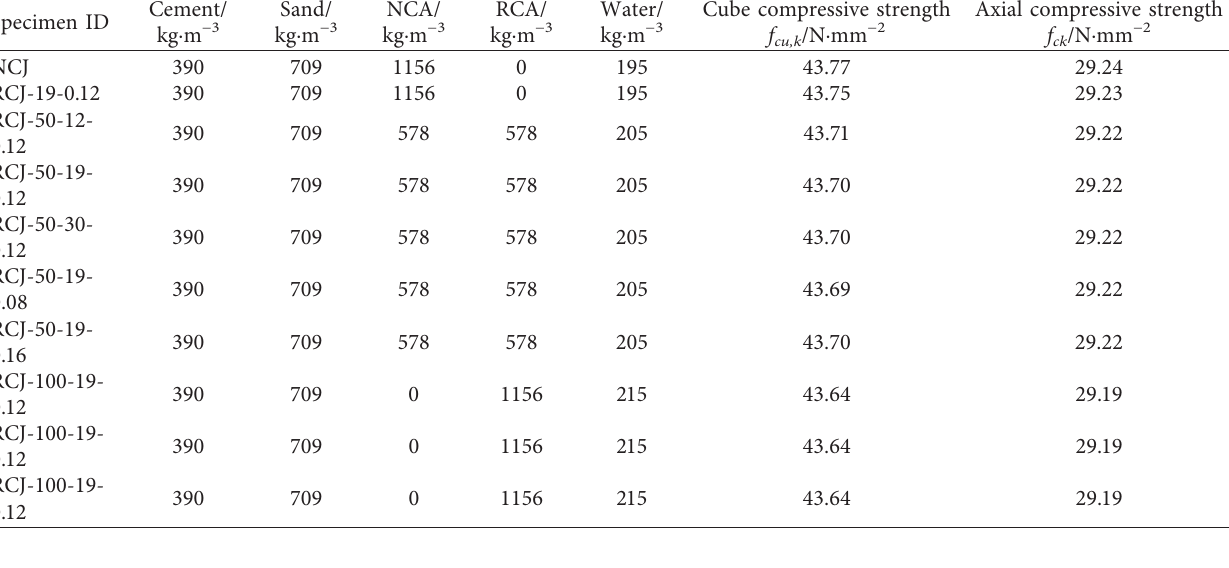
Table 3: Mixture proportion and compression strength.